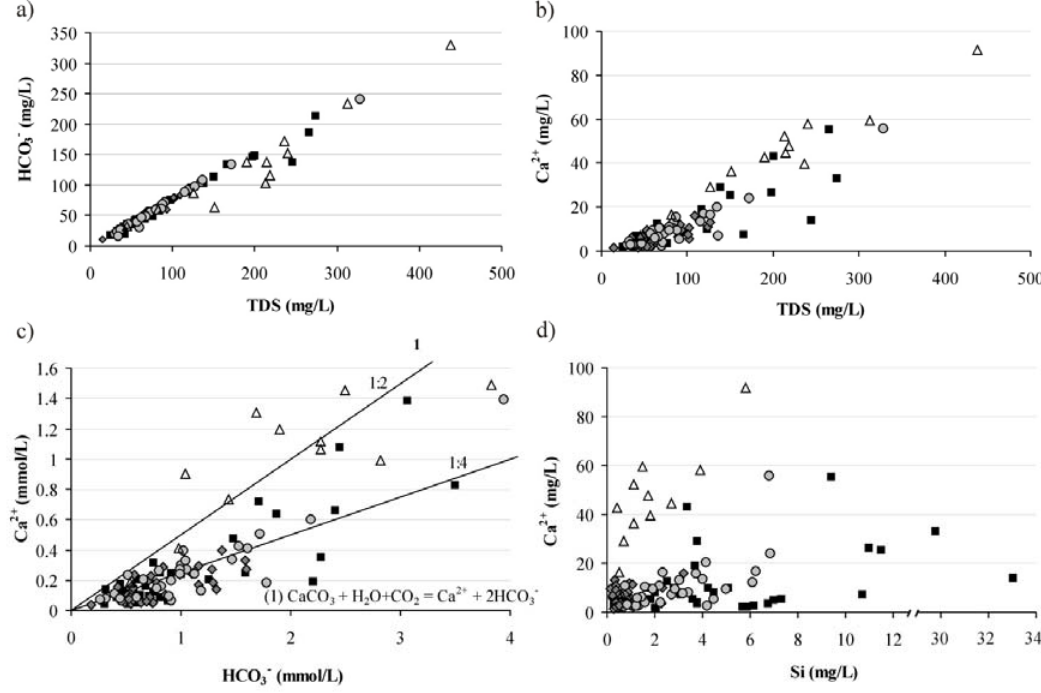
Figure 6. Relationships HCO 3 vs. TDS ( a ); Ca vs. TDS ( b ); Ca vs. HCO 3 ( c ); Ca vs. Si ( d ) for waters from the studied area. Symbols as in Figure 5. TDS—total dissolved solids